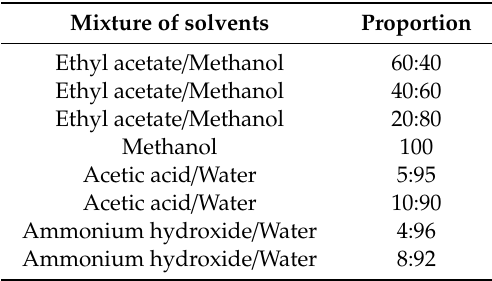
Table 2. Solvents used as the mobile phase during open column